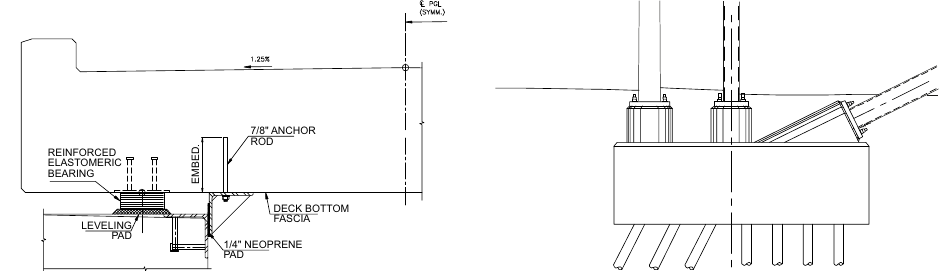
Figure 3. West abutment bearing detail ( left ) and West footing of the arch and pier P3 ( right ). (Adapted from original drawings of PU Facilities and